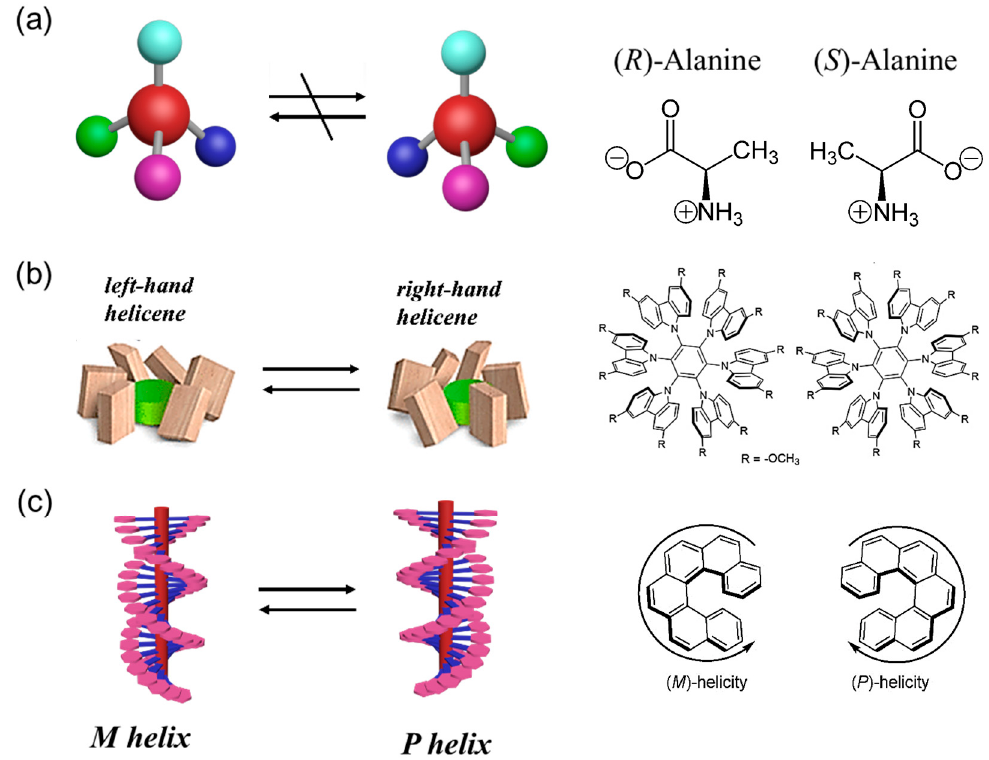
Figure 2. Schematic representation of chiroptical switching between two enantiomers possessing ( a ) configurational chirality, ( b ) conformational chirality and ( c ) helical chirality.